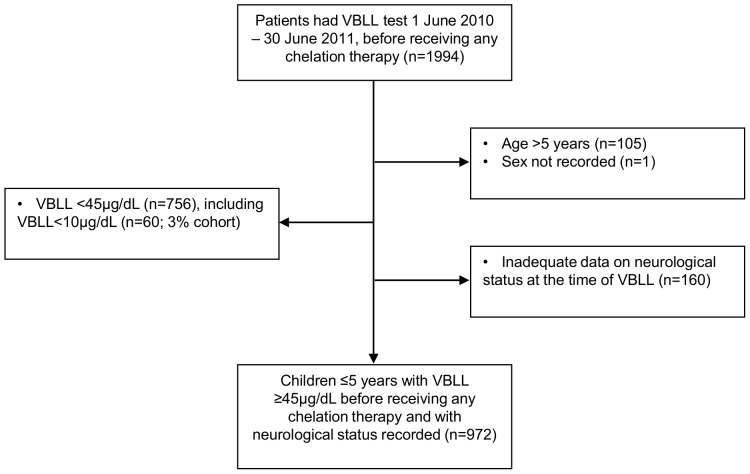
Inclusion and exclusion criteria.VBLL = venous blood lead level.